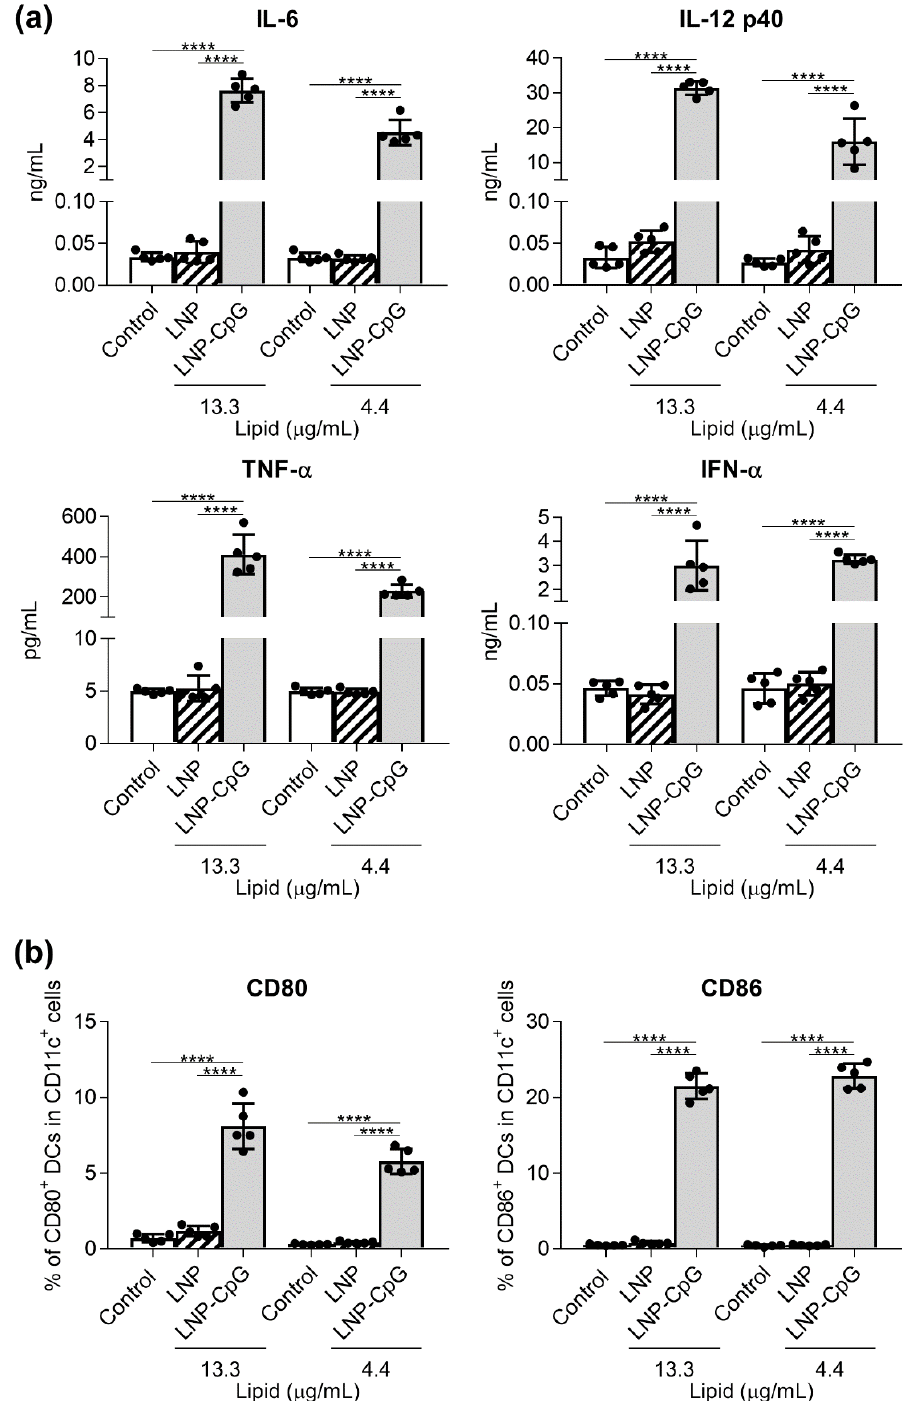
Figure 1. Cytokine production by mouse-derived dendritic cells (DCs) in response to the lipid nanoparticle (LNP) and LNP-cytosine – phosphate – guanine (LNP-CpG) in vitro. Mouse-derived DCs were treated with the LNP (13.3 or 4.4 μ g lipid/mL) or LNP-CpG (13.3 μ g lipid with 1.0 μ g CpG oligodeoxynucleotide (ODN)/mL or 4.4 μ g lipid with 0.33 μ g CpG ODN/mL) for 24 h in vitro. ( a ) Levels of interleukin (IL)-6, IL-12 p40, tumor necrosis factor (TNF)- α and interferon (IFN)- α in the supernatants were measured by using ELISA. ( b ) Expression levels of CD80 and CD86 on DCs were measured by flow cytometry; percentages of positive DCs are shown. ( a , b ) n = 5 per group. Data are means ± SD. **** p < 0.0001, as indicated by Tukey’s test.